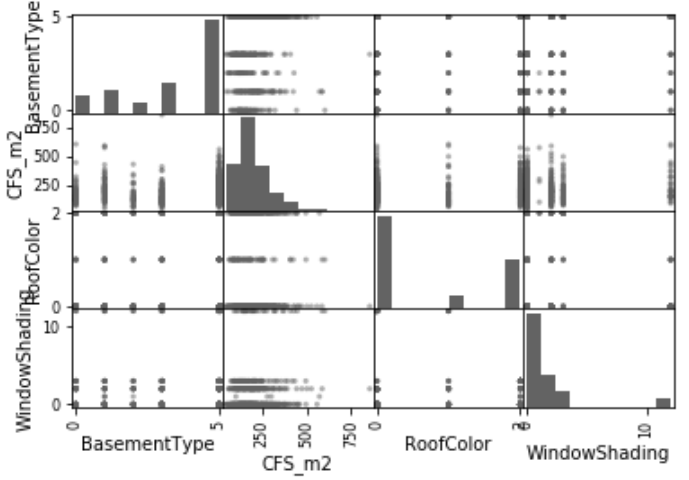
Figure 5. Scatterplot representation of some parameters in the first approach.